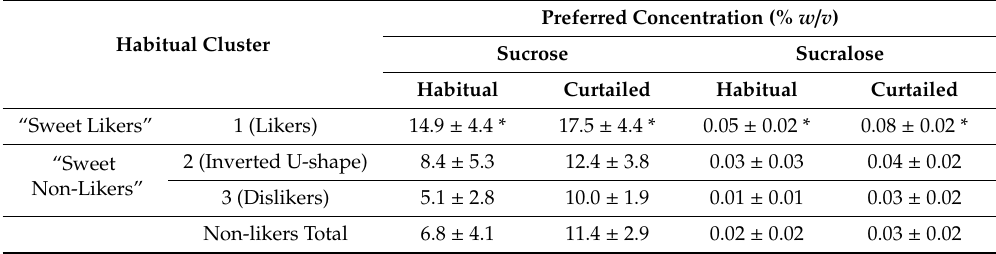
Figure 3. Sucrose and sucralose preferred concentration increased significantly (* p < 0.001) after sleep curtailment. Points represent preferred concentration and error bars represent standard error of the mean. Table 5. Comparison of preferred sweetener concentration after a habitual and curtailed night of sleep for each sweet liking phenotype (determined after a habitual night of